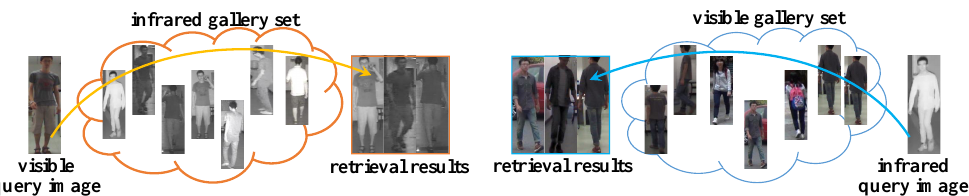
Figure 1. The schematic diagram of visible-infrared person